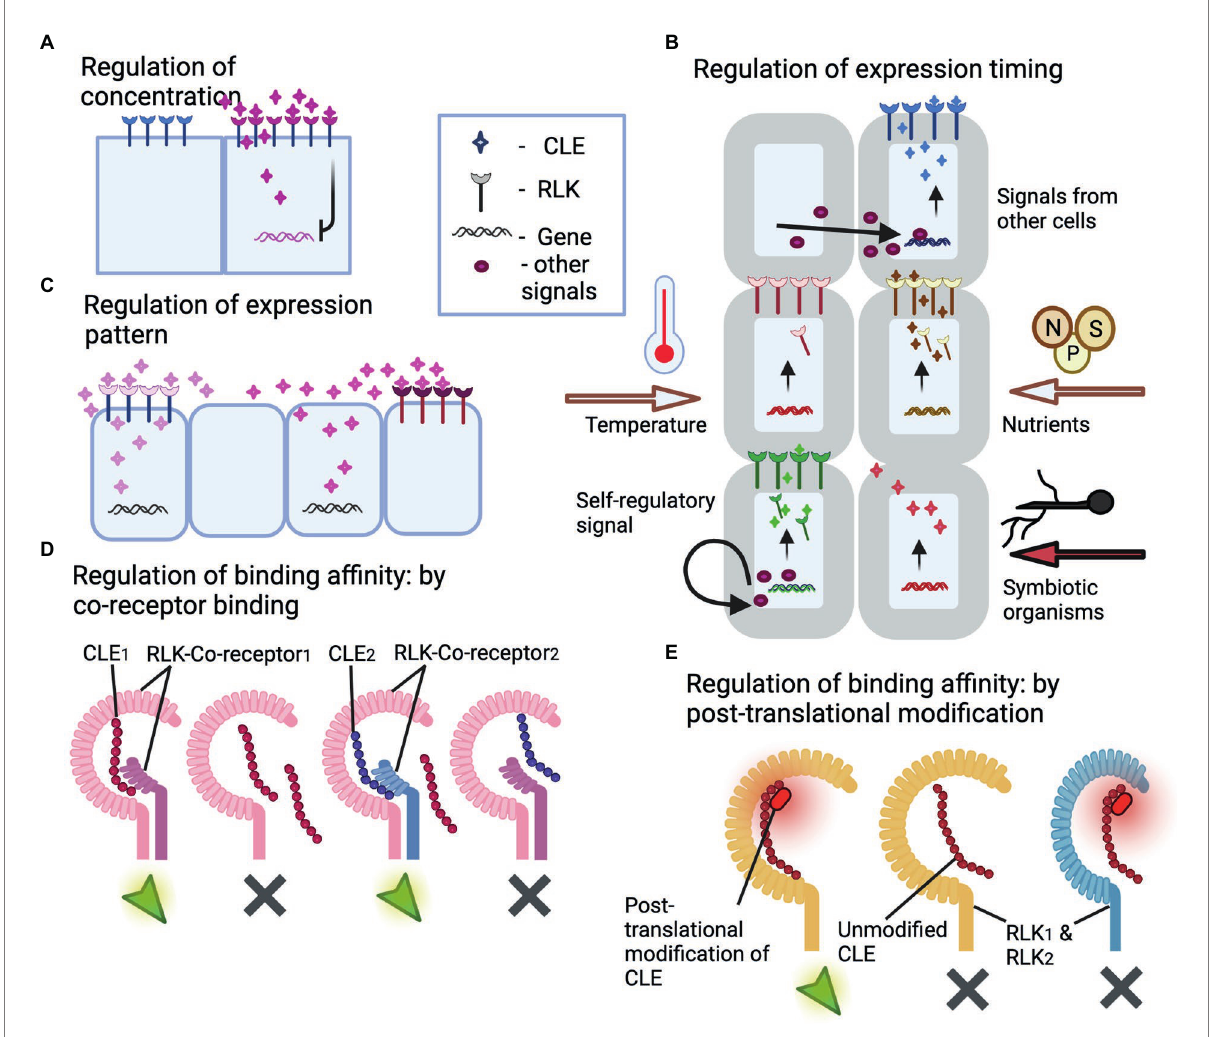
FIGURE 3 Illustrations of regulatory mechanisms that prevent cross-talk between CLE peptides and RLKs. (A) Regulation of CLE peptide concentration. The illustration depicts CLE peptide regulating its own synthesis through negative feedback loop, thus containing itself from excessive expression and spreading leading to cross-talk with other RLKs. (B) Regulation of the timing of CLE and/or RLK expression. The illustration depicts CLE and RLK expression controlled by external stimuli like temperature, nutrient availability, colonization by a symbiotic organism, or after certain regulatory signals produced by the same or other cells. Thus, the temporal control of expression pattern prevents cross-talk and competitive binding. (C) Regulation of the spatial expression pattern of CLEs and RLKs. This illustration depicts spatially separated expression of two similar CLEs avoiding cross-talk with the other RLK. Thus, the spatial control of expression pattern prevents cross-talk and competitive binding. (D) Regulation of CLE-RLK binding affinity through co-receptor binding. The illustration depicts co-receptors offering high binding affinity and thus high specificity to CLE-RLK interaction leading to activation of downstream signaling with no cross-talk. CLEs exhibit high affinity to the RLK that is bound with the corresponding co-receptor (co-receptor1 for CLE 1 ; co-receptor2 for CLE 2 ), whereas they exhibit low binding affinity to the co- receptor unbound RLK or to the RLK bound to a different co-receptor (co-receptor1 for CLE 2 ). (E) Regulation of CLE binding affinity through post- translational modifications. The illustration depicts post-translational modification offering high binding affinity and thus high specificity to CLE- RLK interaction leading to activation of downstream signaling with no cross-talk. The CLE peptide with post-translational modification binds to the corresponding RLK (RLK 1 ) with higher affinity compared to its unmodified counterpart and thus avoids cross-talk with the non-specific RLK 2 . The green arrows and gray crosses in (D,E) represent activated and non-activated downstream